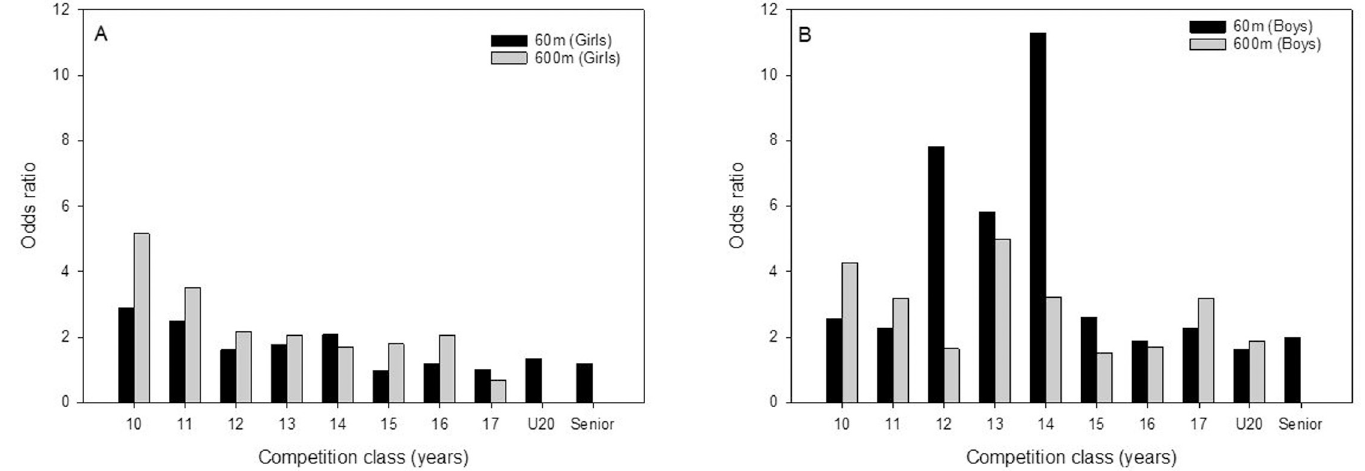
Fig 2. An overview of odds ratio (OR) of being among the top 100 athletes and born in Q1 compared to Q4 for girls (A) and boys (B).